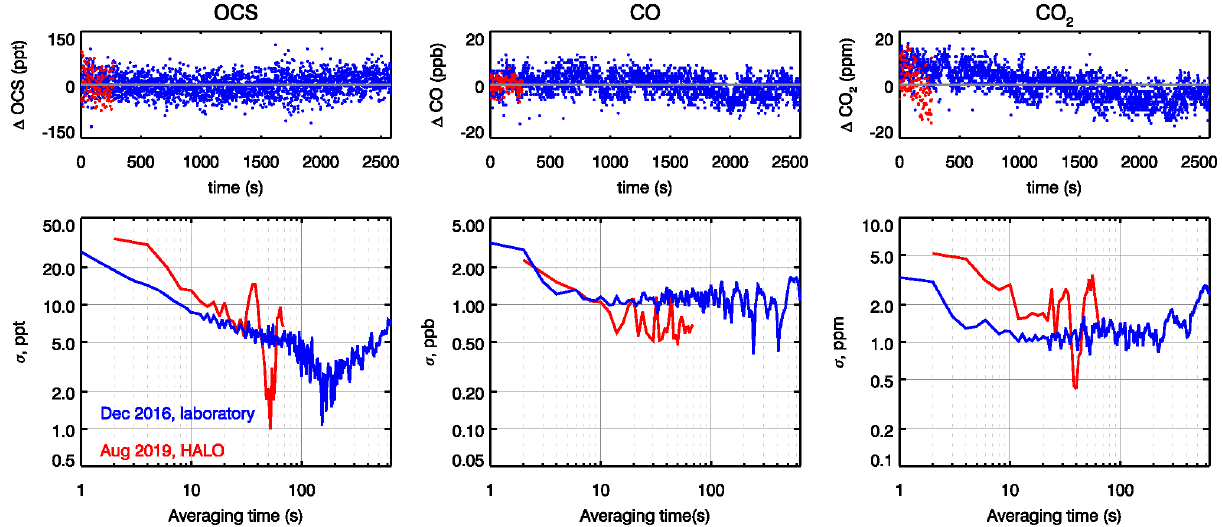
Figure 9. Allen deviation plots for OCS, CO and CO 2 based on measurement of the same standard by AMICA over an extended period of time (45min with 1s time resolution in the laboratory test in December 2016, blue line, and 5min with 2s time resolution inside HALO at the start of the SouthTRAC